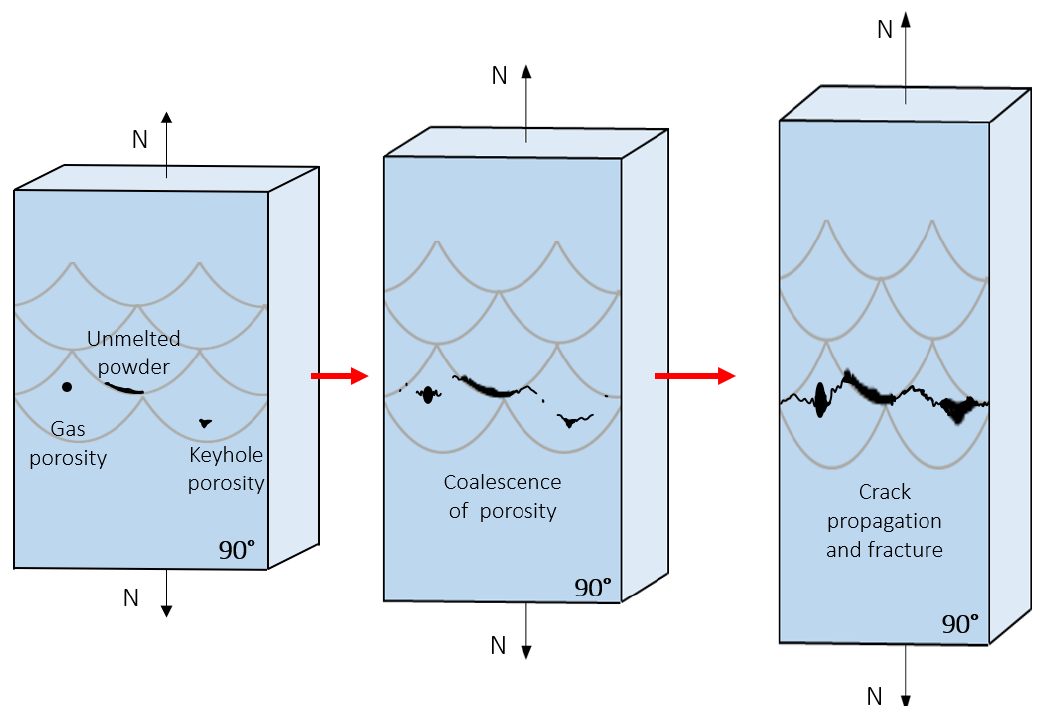
Figure 19. Crack coalescence and propagation for 90°.